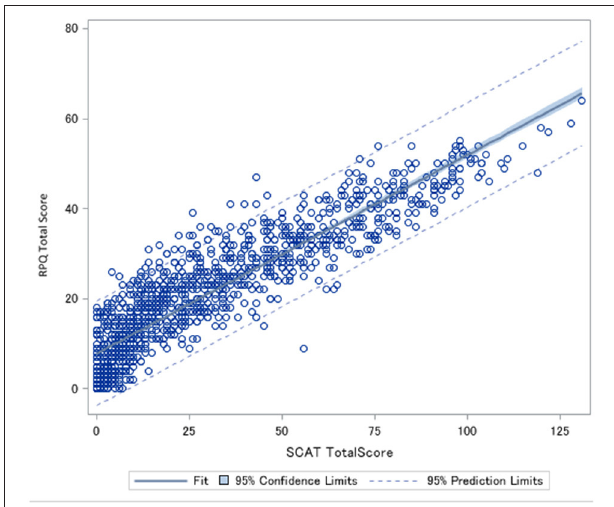
FIGURE 1 | Spearman correlation between Rivermead post-Concussion Symptoms Score (RPQ) total score and Sports Concussion Assessment Tool (SCAT) total score. Rho = 0.91 p < 0.0001.